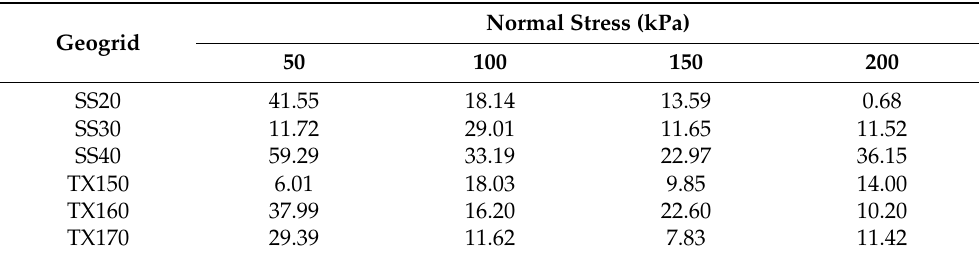
Table 2. Percentages of shear strength variation (%) for fine sand–biaxial geogrid interfaces and fine sand–triaxial geogrid